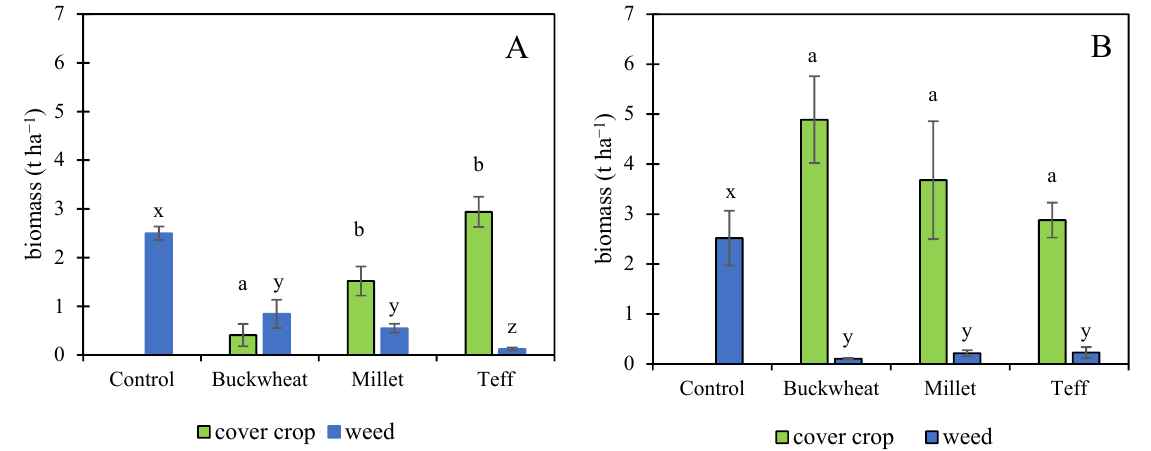
Figure 2. Average dry biomass of cover crops and weeds produced at Bringelly ( A ) and Lansdowne ( B ). The cover crop and weed biomass data were transformed before analysis, and backtransformed data for both cover crop weed biomasses are presented. Error bars represent approximate standard errors of mean calculated based on backtranformed values. Different letters show significant differences ( p < 0.05) (ab for weed biomass and xyz for crop biomass).